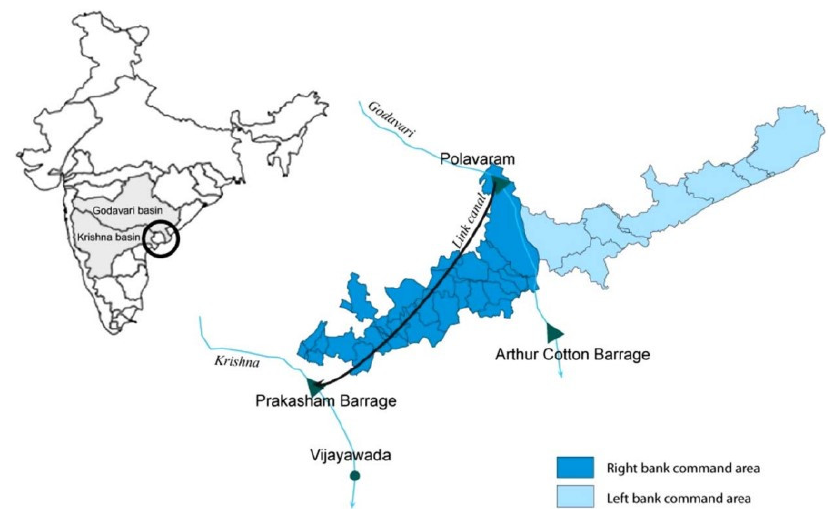
Figure 2. Location of Polavaram site in Godavari River Basin, Andhra Pradesh, India [98].